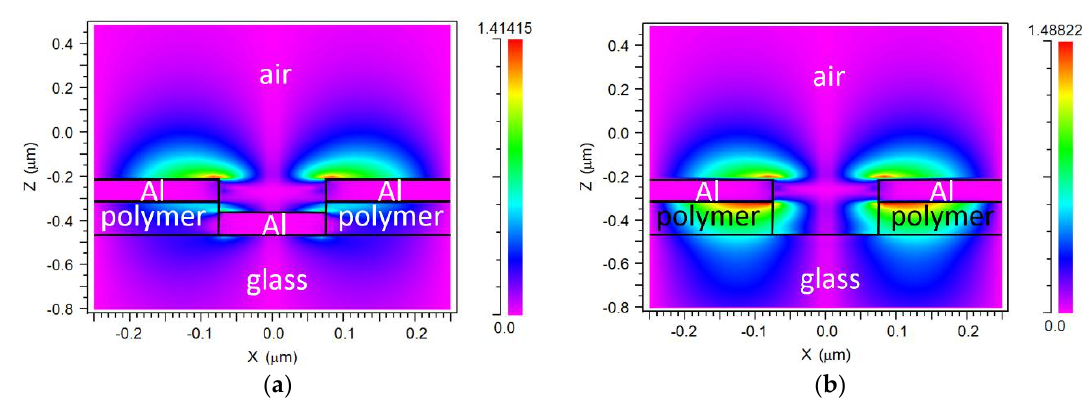
Figure 4. Reflectance spectra of a 500 nm period Al/polymer plasmonic 2D crystal without Al disks (inset) for d = 150 nm and h = 150 nm. Al metal thickness is 100 nm. Blue and red (dotted) lines correspond to t bio = 0 and t bio = 20 nm, respectively. A, B, and C indicate minima (dips) of the curve for t bio = 0.